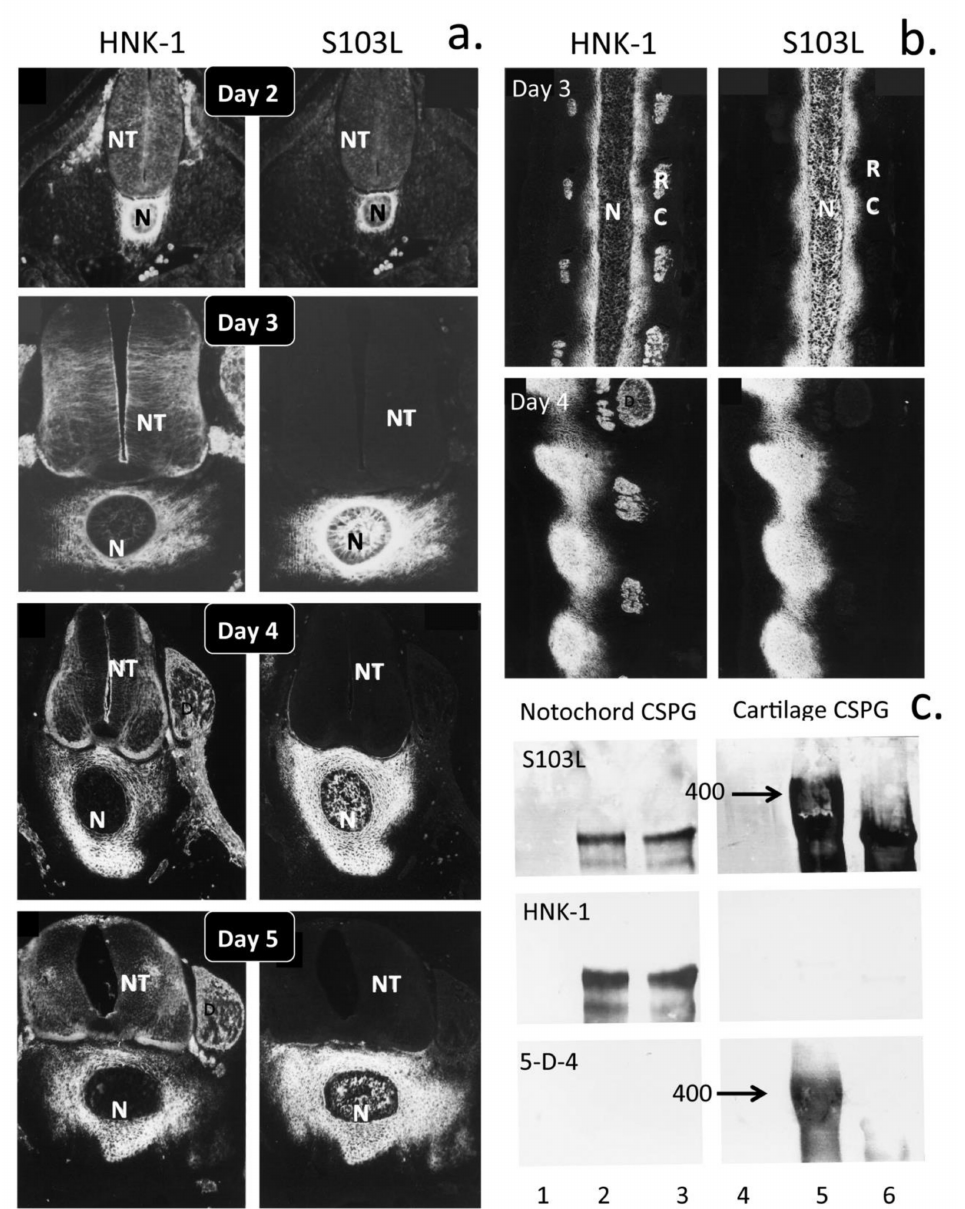
Figure 9. Fluorescent immunolocalisation of HNK-1 and aggrecan S103L epitope in 2–5-day-old chick trunk sections associated with the neural tube (NT) and notochord (N) development ( a , b ) and in Western blots ( c ) of purified chick notochordal and cartilage aggrecan. Keratan sulphate was also immunolocalised on blots using MAb 5-D-4. Notochordal aggrecan was S103L and HNK-1 positive but did not contain KS and was of a smaller molecular weight; the 400-kDa cartilage aggrecan species was not detected. Cartilage aggrecan did not stain with the HNK-1 antibody. The S103L antibody identifies the sequence 585 XXX Glu Ileu Ser Gly Phe Leu Ser Gly Asp Arg 615 in the CS attachment domain of aggrecan. Images reproduced from